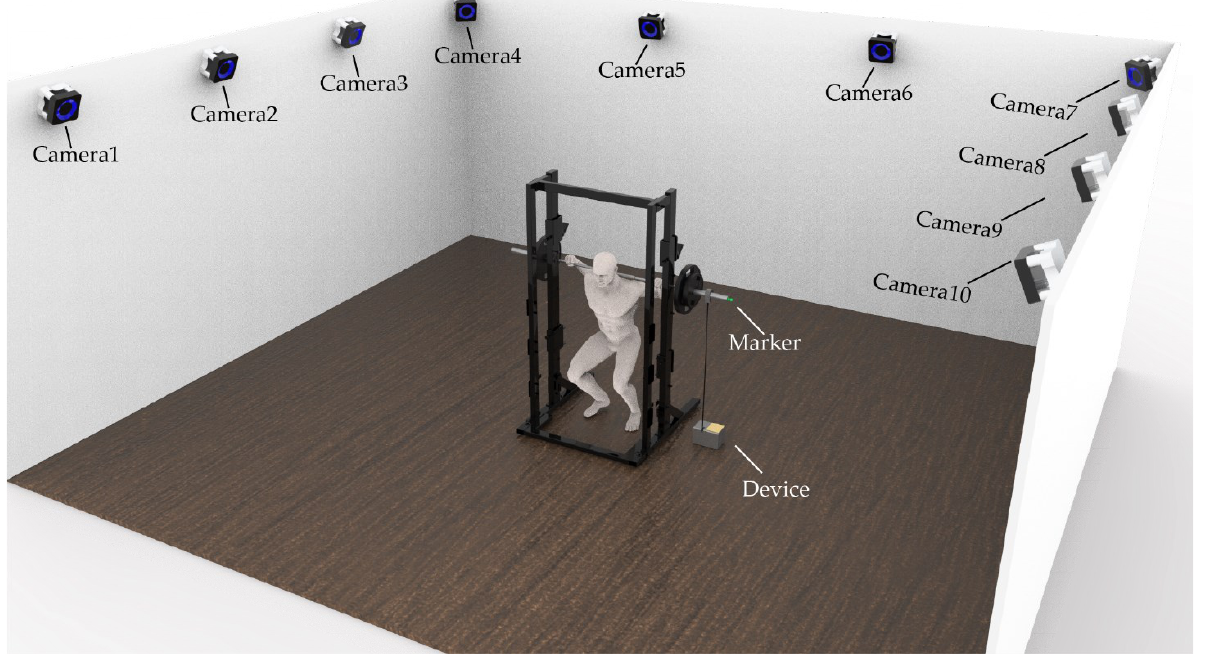
Figure 6. Distribution of the monitoring systems in the test.